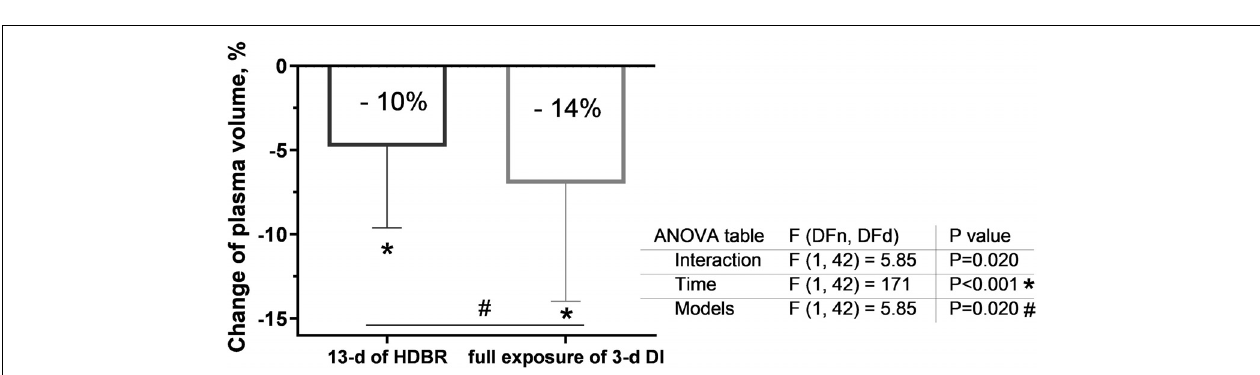
FIGURE 3 | Changes in plasma volume on the 13th day of head-down bed rest (HDBR) and at the end of the 3-day dry immersion (DI). Data are the mean ± SEM. * p < 0.05 vs. before exposure; # p < 0.05 between groups.